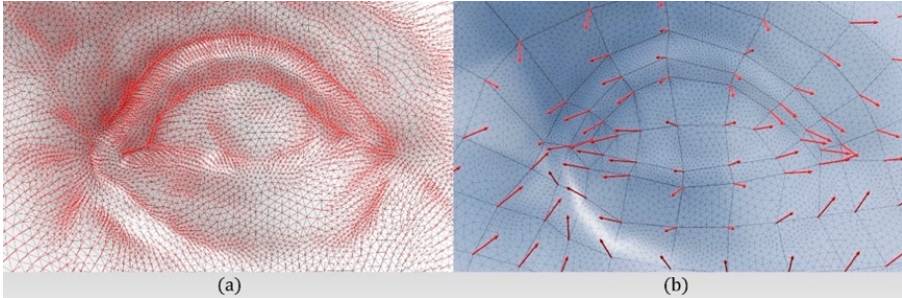
Figure 11. Marsili bust (detail): the amount of vertex normals ( A n ) to be baked is crucial for the baking process ( a ); in ( b ) are shown the corresponding normals of the low-resolution counterparty